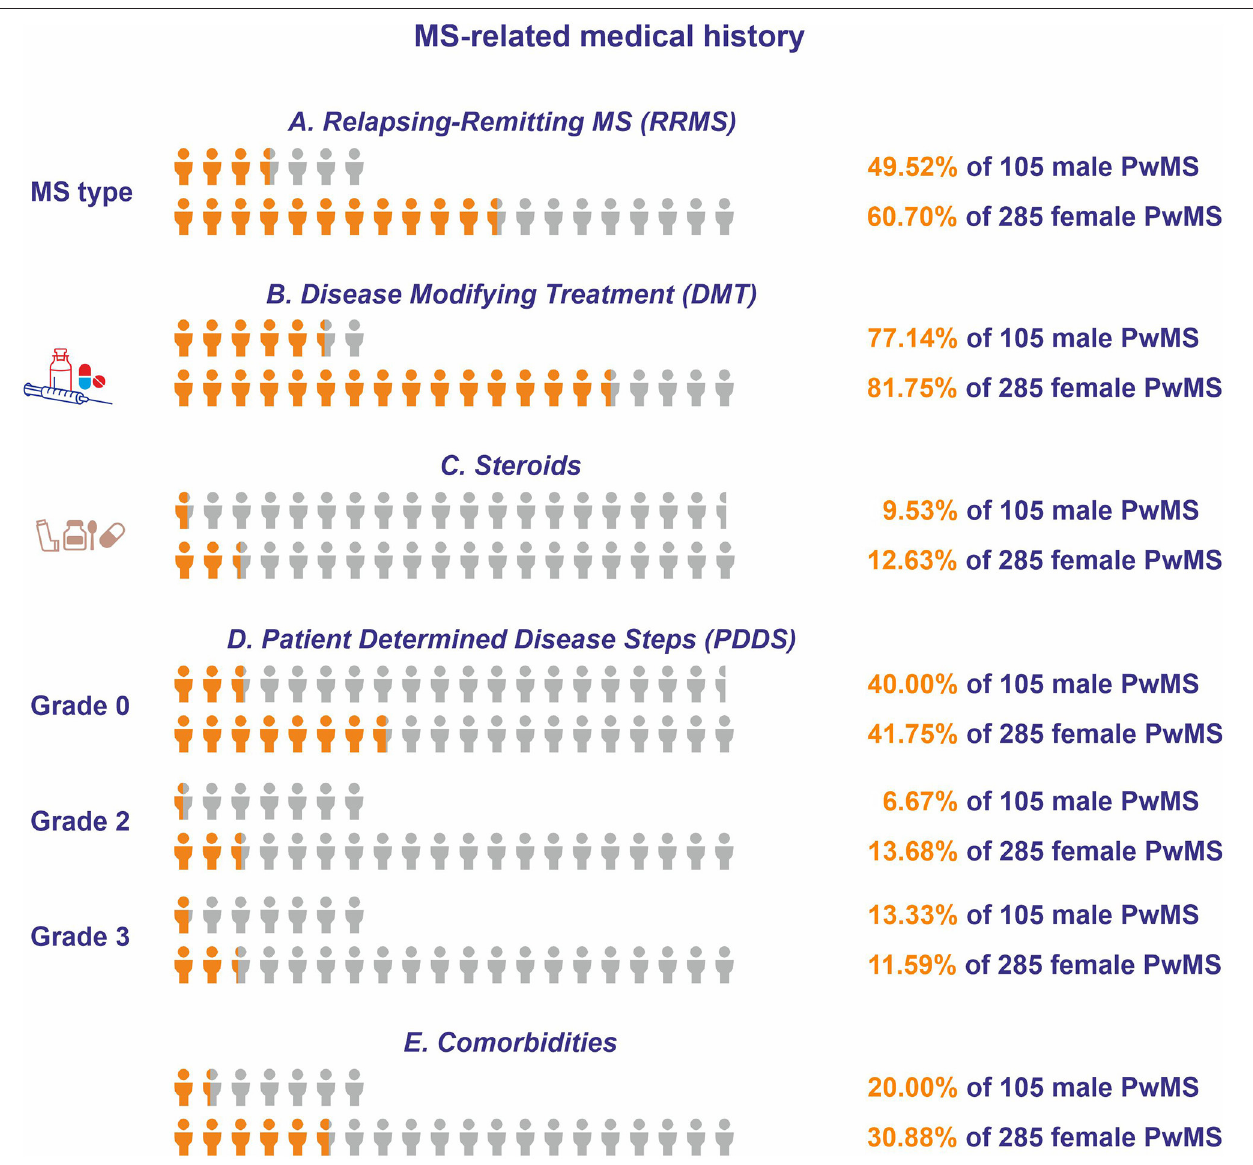
FIGURE 2 | Multiple sclerosis-related medical histories for respondents of Questionnaire A. The orange icon of the human form depicts the portion of the male and female respondents who (A) had relapsing-remitting form of MS (RRMS), (B) received disease-modifying therapy (DMT), (C) received steroids during the 2 months prior to participation, (D) had patient determined disease steps (PDDS) of grade 0, grade 2, or grade 3, and (E) reported comorbidities. The light gray icon depicts the total number of male and female people with MS